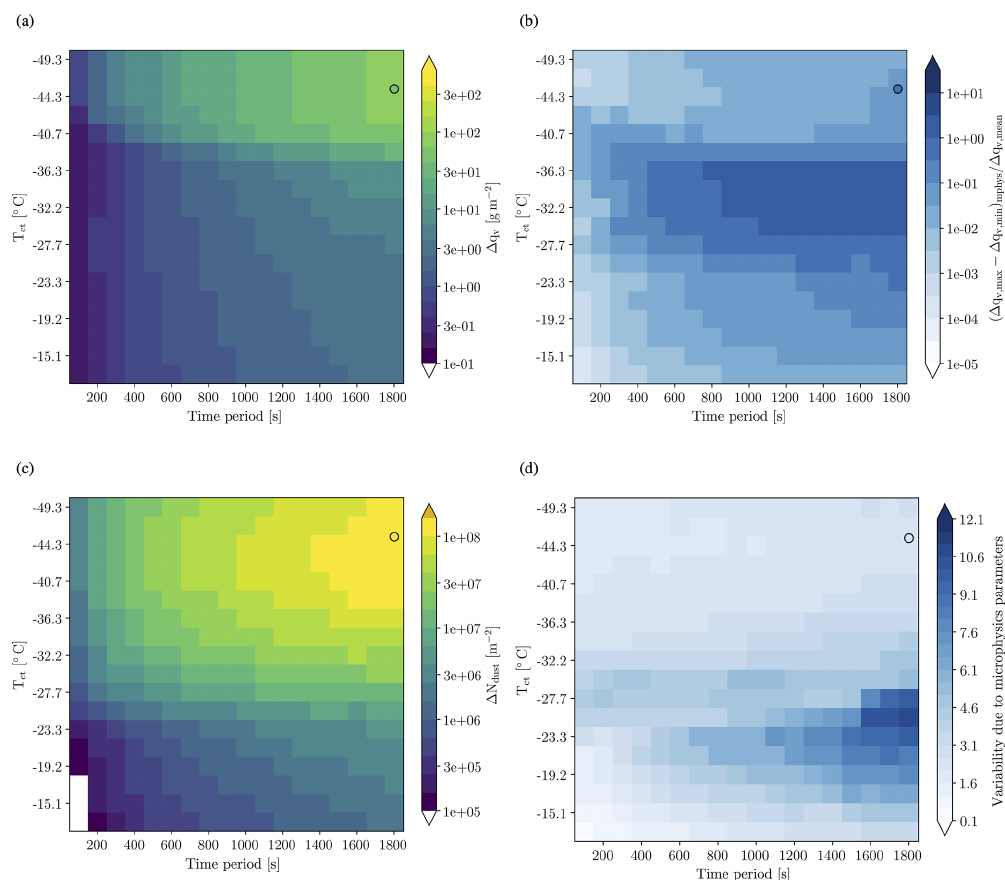
Figure 10. Modification of (a, b) water and (c, d) dust profiles across wave clouds with vertical extent z c of 2km and various cloud top temperatures (ordinate) as well as periods (abscissa). Panels (a) and (c) show the mean value across KiD simulations with different ice nucleation and soluble fraction descriptions. Panels (b) and (d) show the variability resulting from varying the ice nucleation representation and the soluble fraction assumption, i.e. ((cid:49) Lagr q t | max − (cid:49) Lagr q t | max )/(cid:49) Lagr q t | mean . The colour-filled circles indicate the location of the ICE-L case study in the phase space. The colour of the circle shows the value obtained from the UM simulations of the ICE-L